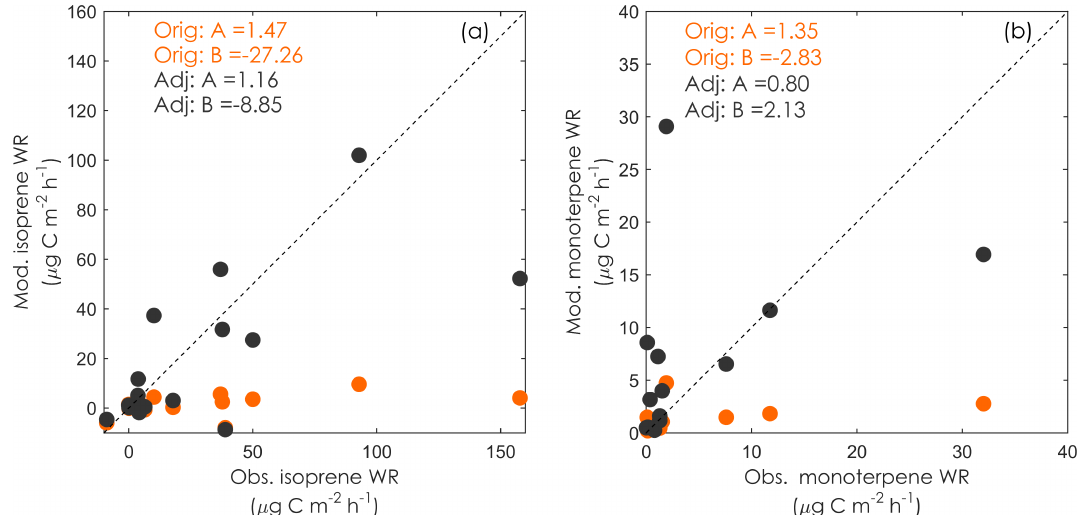
Figure 5. Scatter plot of the modelled (Mod.) and the observed (Obs.) warming responses (WRs) for both isoprene (a) and monoterpene (b) , using the adjusted (Adj) and the original T (Orig) response.